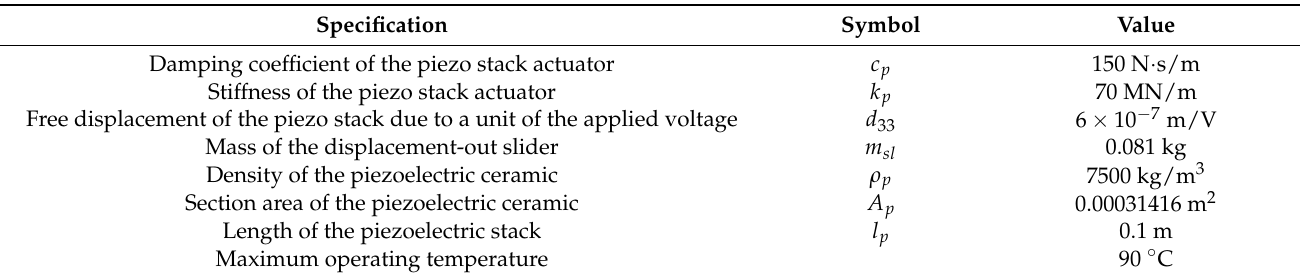
Figure 4. Configuration of the piezoelectric stack. Table 1. Design parameters of the